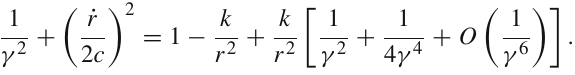
where ˜ r 0 is an (cid:7) -independent constant and ρ is an (cid:7) - dependent variable which is of O ( 1 ) as (cid:7) →